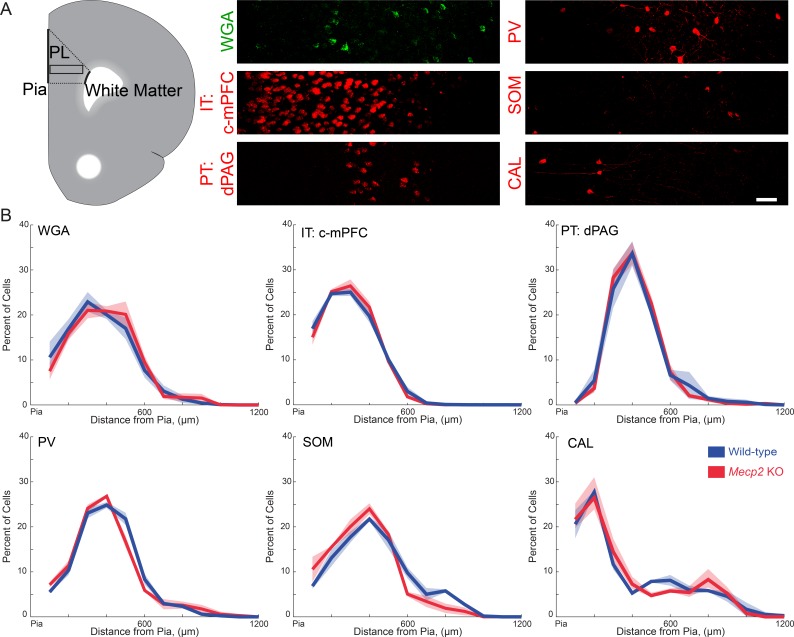
Spatial distribution of different neuronal subtypes in the mPFC that are innervated by vHIP fibers in wild-type and Mecp2 KO mice.(A) Schematic of the PL region of the mPFC (left), and representative images of immunostaining for trans-synaptic WGA; PV, SOM, and CAL interneurons; and retrograde FluoroGold labeling of c-mPFC and dPAG pyramidal neurons in the PL-mPFC. Scale bar 50 μm. (B) Percent of each neuronal subtype as a function of distance from the pial surface (inter-hemispheric midline) (n = 15 sections from five mice each for WT and Mecp2 KO WGA staining, n = 9/3 for both WT and Mecp2 KO mice with c-mPFC, dPAG, PV, SOM, and CAL). Mean ± SEM (shaded area).